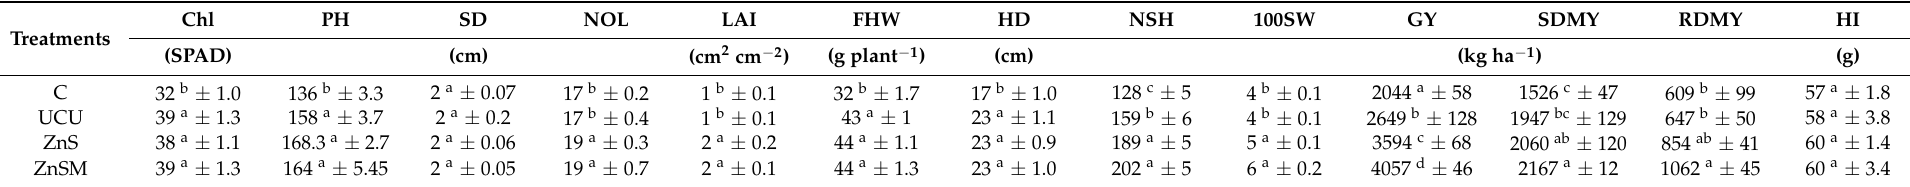
Table 1. Mean ( n = 3, ± 1 SE) growth and yield parameters of sunflower crop as influenced by uncoated urea (UCU), coated urea with zinc sulfate (ZnS) and zinc sulfate plus molasses (ZnSM). C stands for untreated control. Different small letters within a column indicates the significant difference among treatments at 5% probability level after Tukey HSD test.